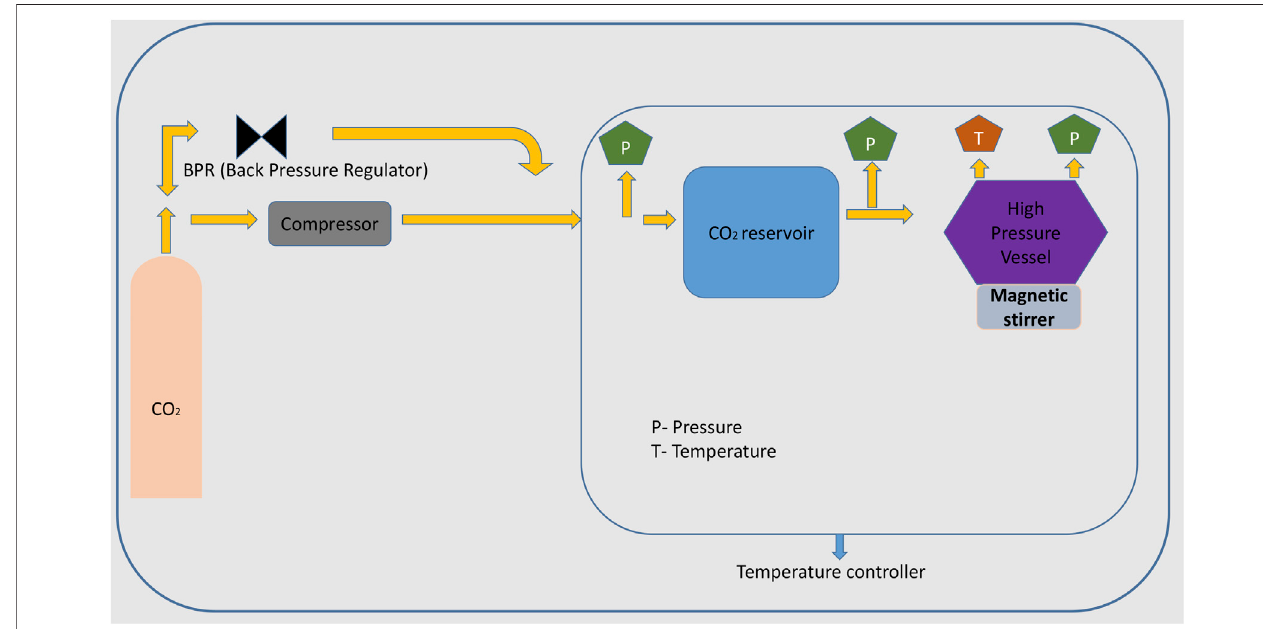
FIGURE 2 | Schematic diagram of supercritical solvent crystallization.